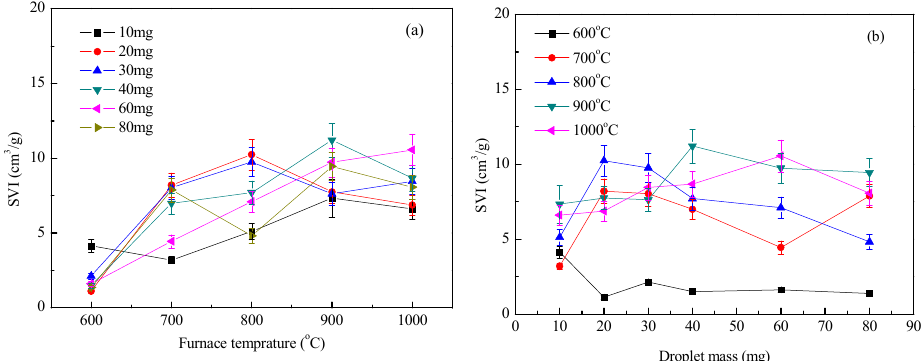
Figure 6. Waste liquor swelling volume index (SVI) under nitrogen condition: ( a ) SVI with furnace temperature; ( b ) SVI with droplet mass.